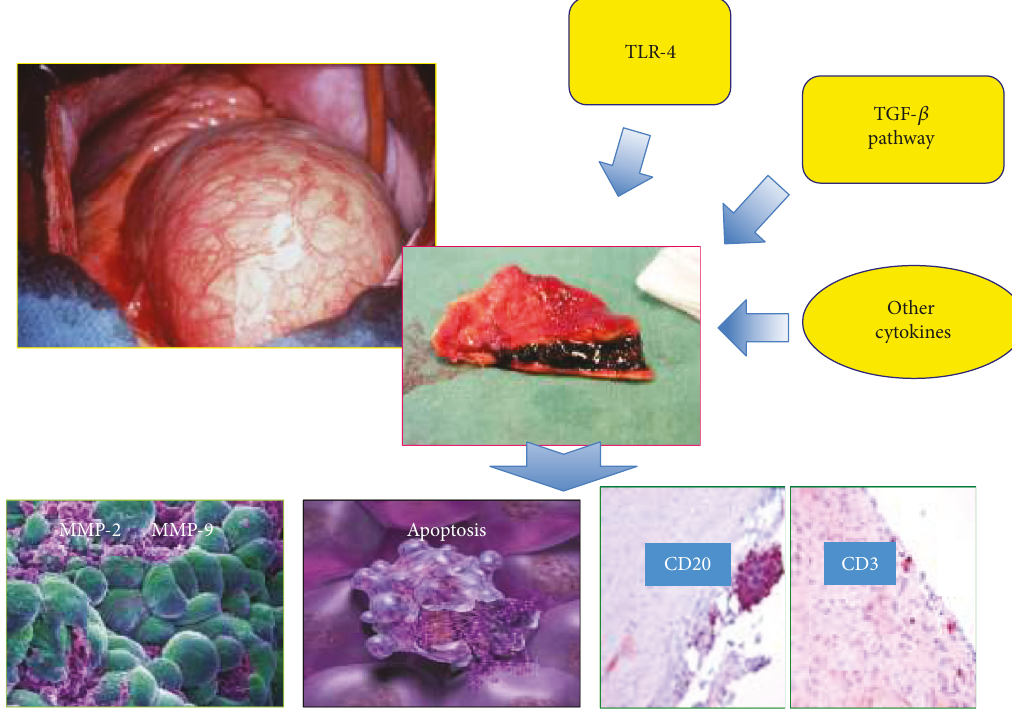
Figure 1: Thoracic aortic aneurysm as an emerging in fl ammatory